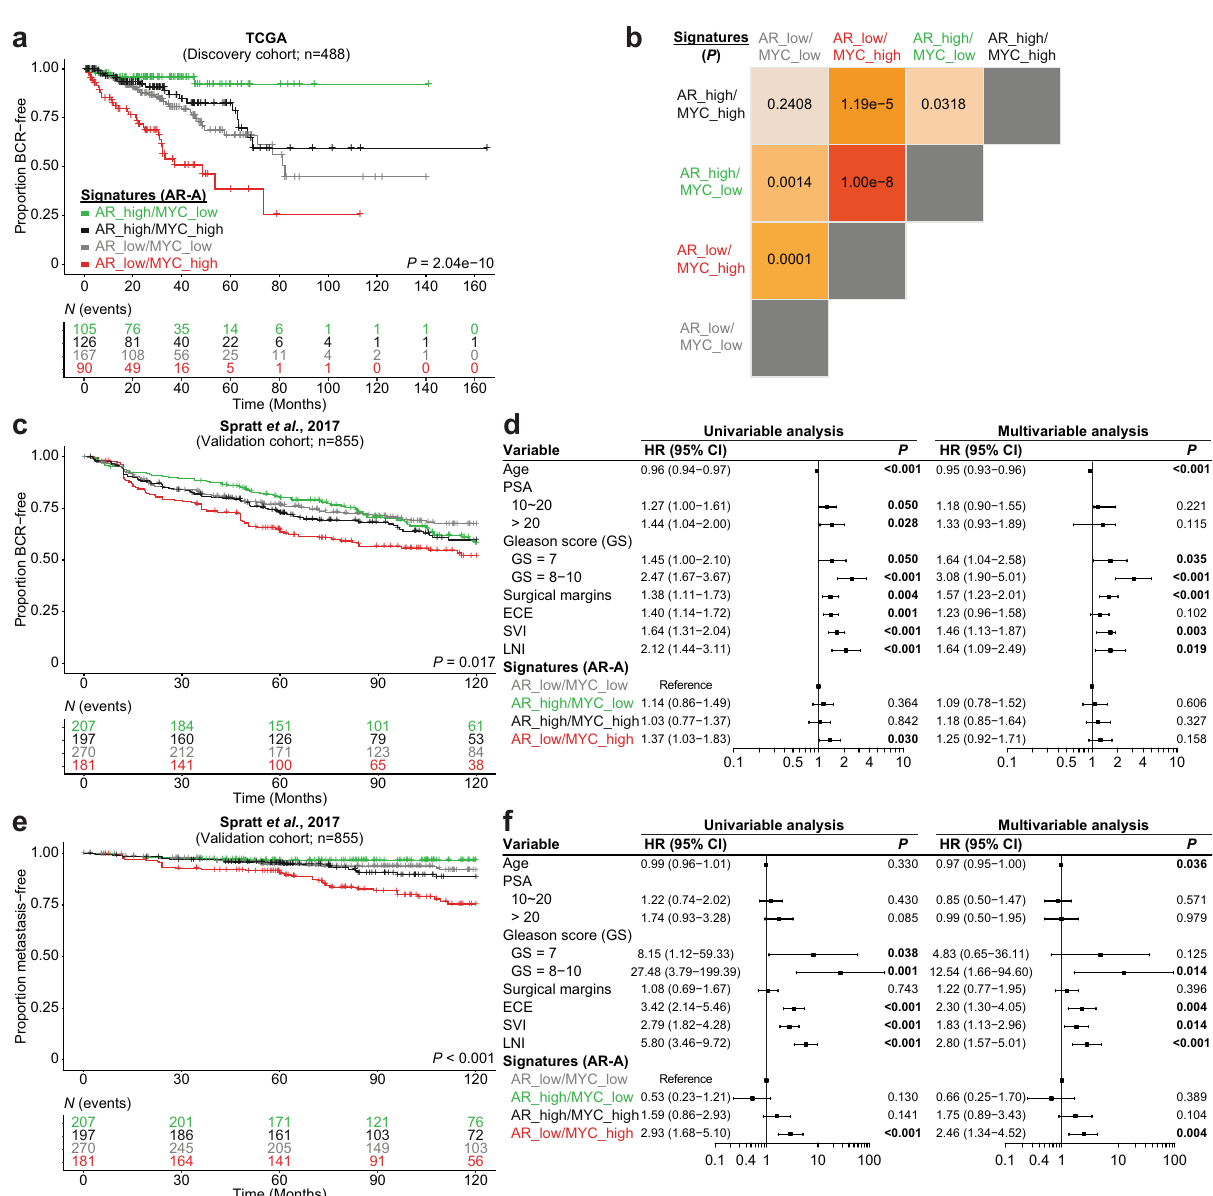
Fig. 5 Divergent MYC and AR transcriptional programs dictate disease progression. a , b Kaplan – Meier curves ( a ) and log-rank tests ( b ) reveal that patients bearing a primary tumor characterized by low AR-activity (AR-A) and concurrent high MYC transcriptional signature (Hallmark) have a shorter time to biochemical recurrence (BCR) within the discovery cohort (TCGA). c , d Kaplan – Meier curves ( c ), univariable and multivariable analysis ( d Cox proportional hazards model) con fi rms that tumors with concurrent low AR-A and high MYC transcriptional signatures develop BCR after radical prostatectomy more rapidly than low AR-A tumors without an active MYC transcriptional program in the validation cohort (Spratt et al., 2017 35 ; n = 855; HR ± 95% CI). e , f Kaplan – Meier curves ( e ), univariable and multivariable analyses ( f Cox proportional hazards model) reveal that tumors with concurrent low AR-A and high MYC transcriptional signatures are more likely to develop a metastatic disease ( n = 855; HR ± 95% CI). PSA: prostate-speci fi c